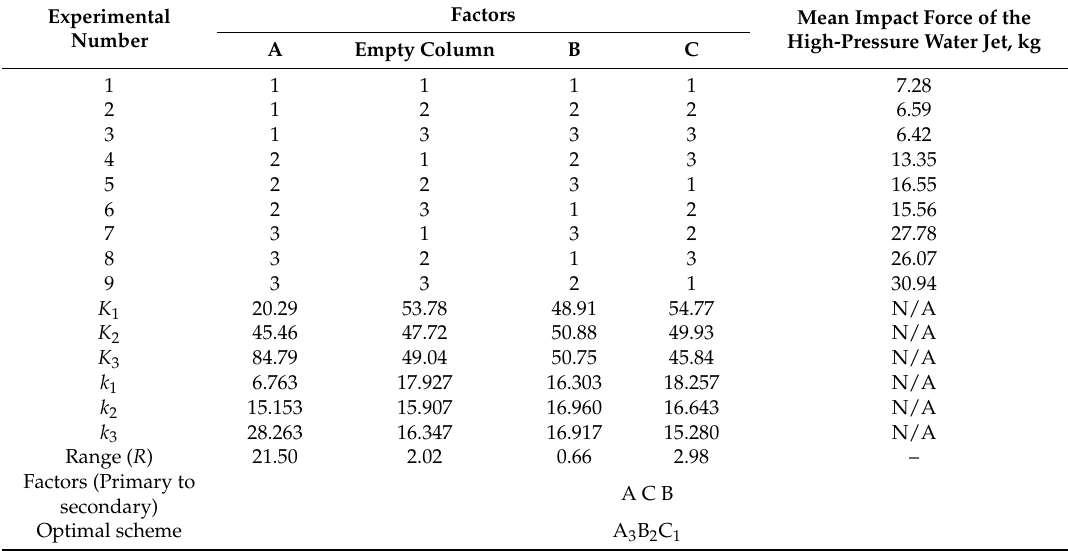
Table 5. Range analysis of the impact force of the high-pressure water jet produced by straight cone nozzles with different